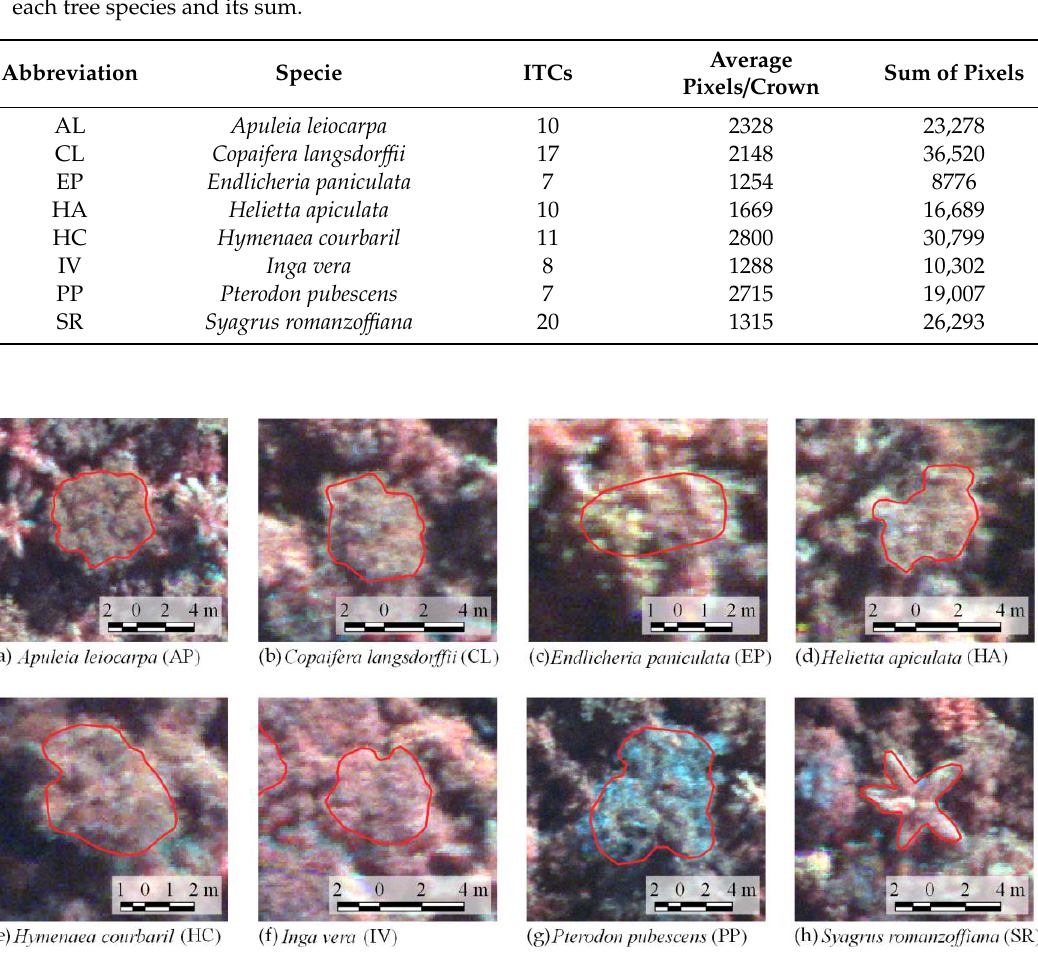
Table 1. Tree species identified in the field and their characteristics 1 .